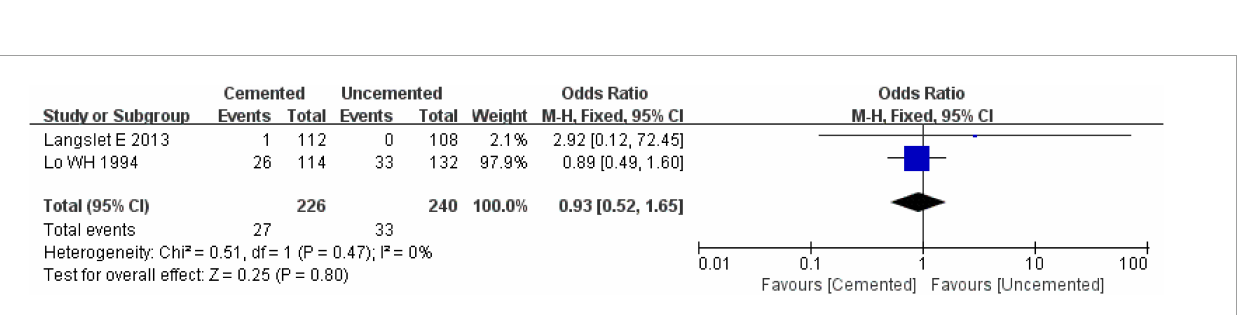
FIGURE16 Forest plot for comparison of acetabulum erosions between cemented bipolar hemiarthroplasty (CBH) group and uncemented bipolar hemiarthroplasty (UCBH)